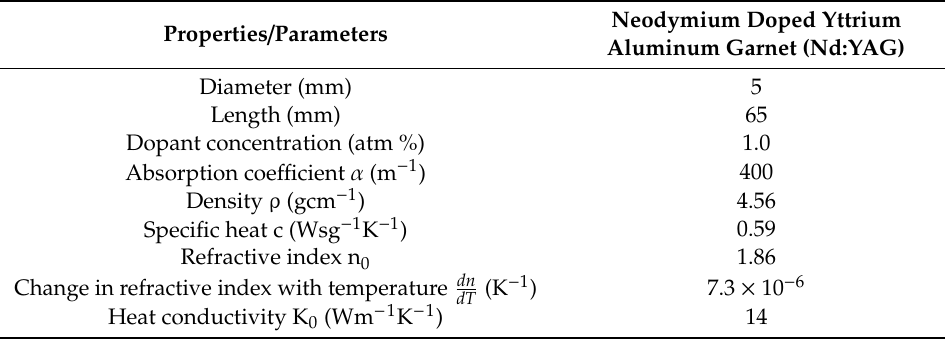
Table 1. The properties of the Nd:YAG used in the